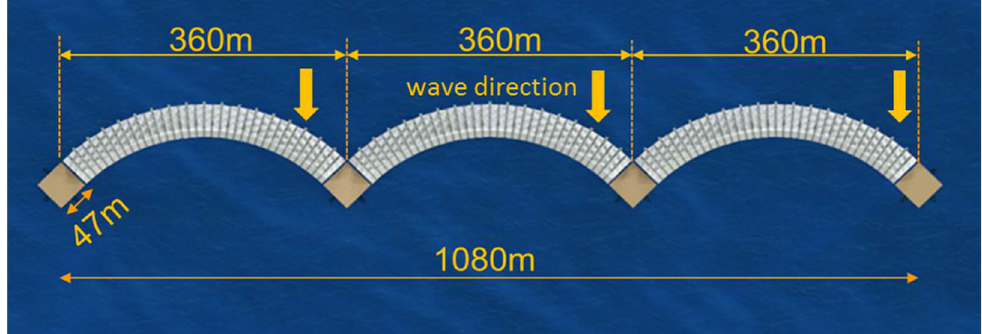
Figure 1. Conceptual design of modular floating concrete breakwater-windbreak (wave direction marked by arrows).